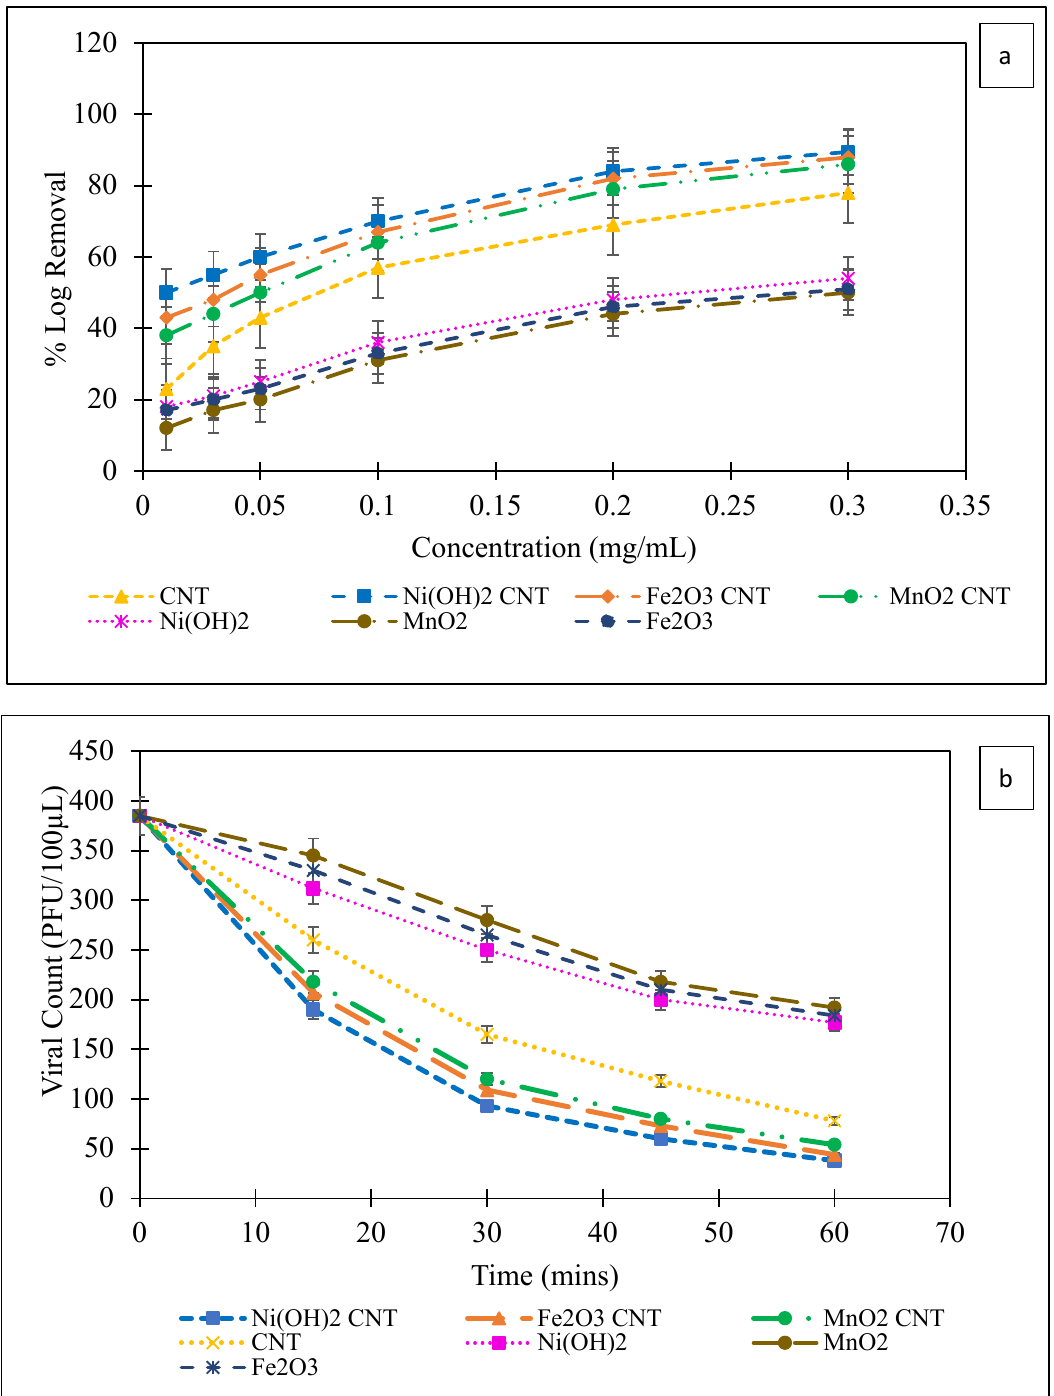
Figure 6. ( a ) Percentage log removal of MS2 phages at different concentrations of MO and MO-CNT; ( b ) MS2 phage reduction kinetics at 0.3mg/mL.